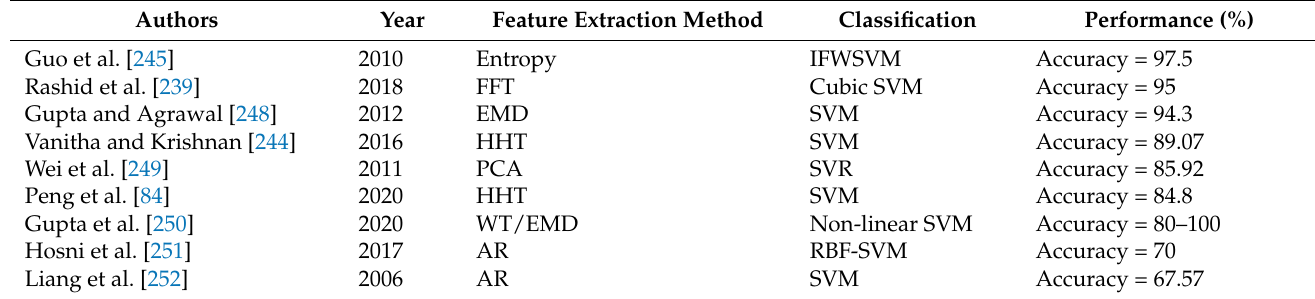
Table 4. Classification accuracy of the selected feature extraction methods with the SVM classifier for a mental workload task.